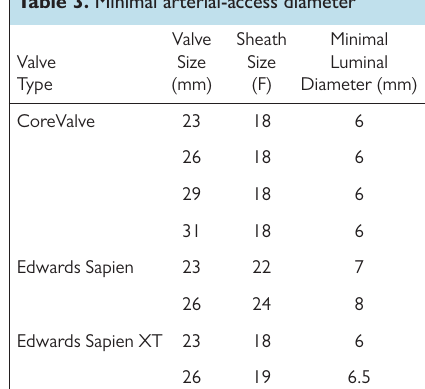
Table 3. Minimal arterial-access